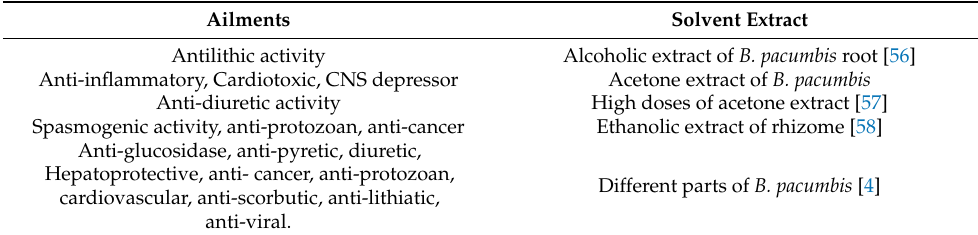
Table 5. Modern uses of various extracts obtained from Bergenia pacumbis (Buch.-Ham. ex D.Don) C.Y.Wu &